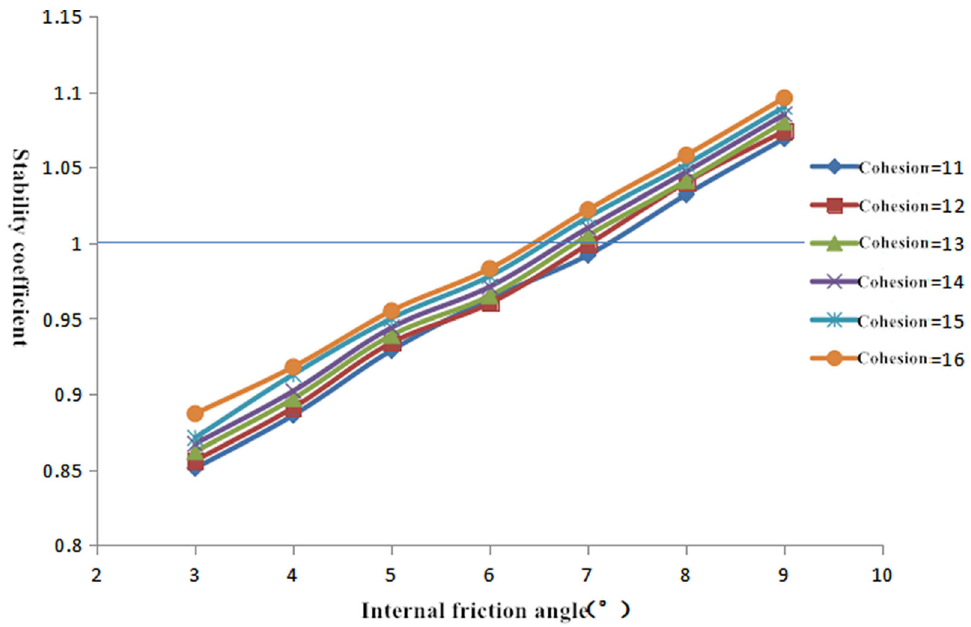
Fig. 10 Relationships among varying cohesion and internal friction angles, and the coefficient of stability of the slope